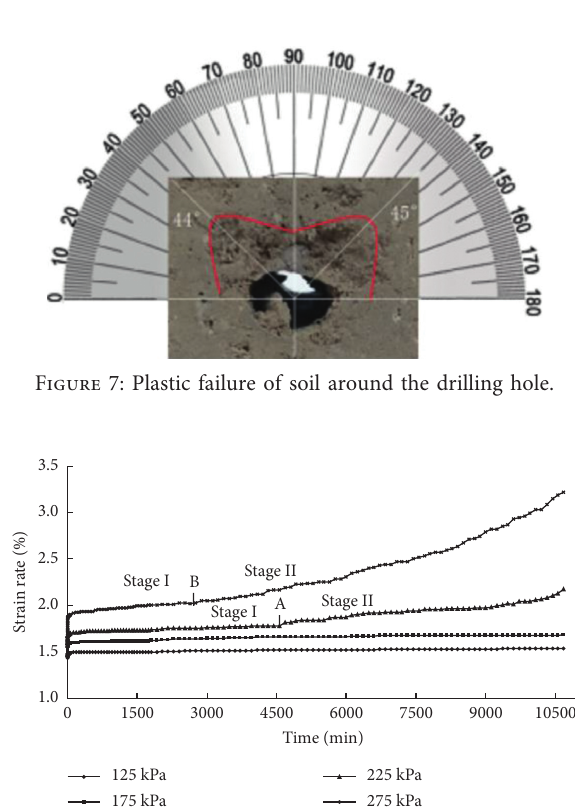
Figure 9: Burgers model.